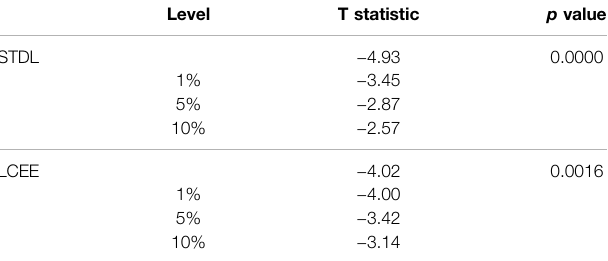
TABLE 5 | Unit root test